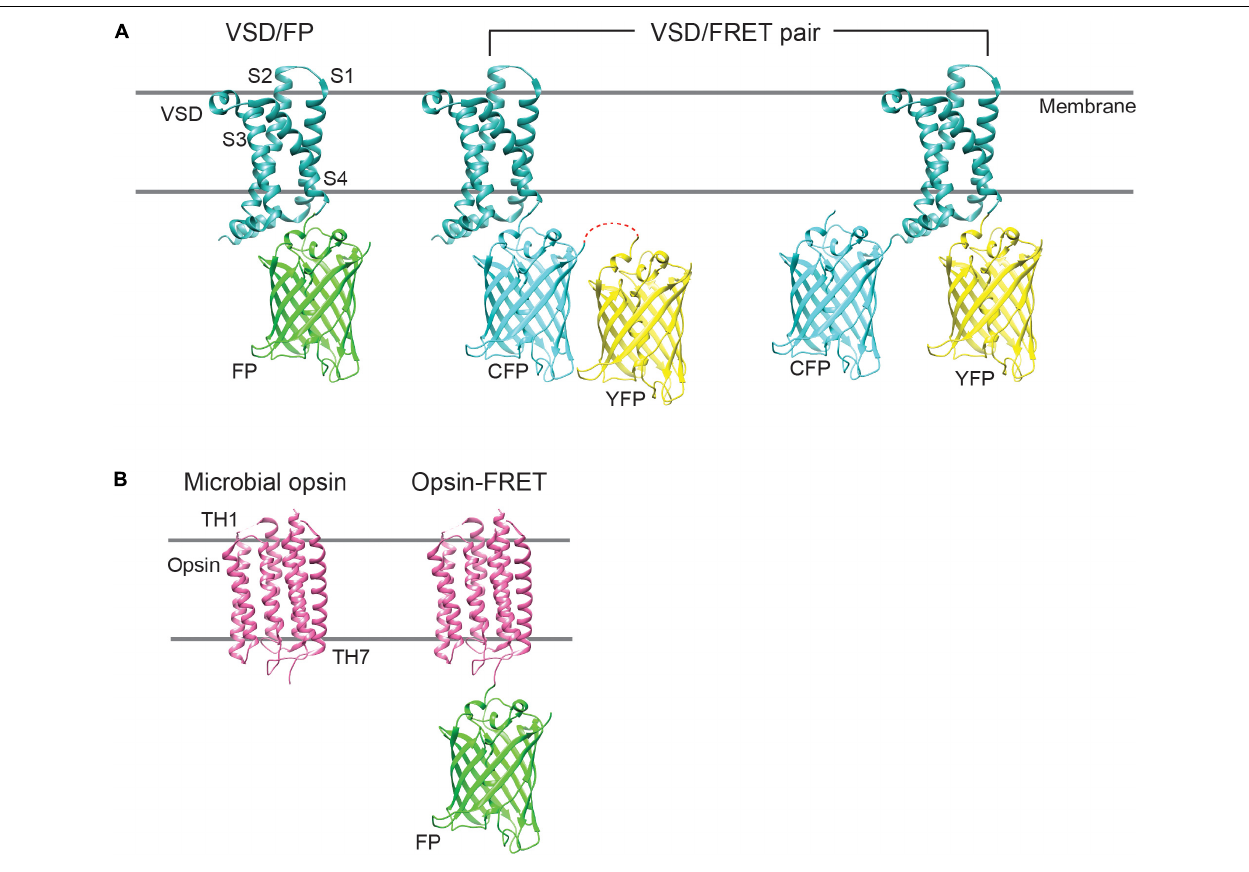
FIGURE 1 | Cartoon showing the different GEVI designs. (A) The majority of type 1 GEVIs consist of a molecular fusion of an isolated VSD, derived from a voltage-sensitive phosphatase, and a single FP, or a FRET FP pair. In FRET constructs, the FPs may be fused in tandem or to either terminus of the VSD. CFP, cyan fluorescent protein; YFP, yellow fluorescent protein. (B) Type 2 GEVIs comprise standalone microbial opsins, which possess seven transmembrane helices (TH1–TH7), or opsin-FRET constructs, where the opsin may be fused to a fluorophore. Microbial opsins exhibit broad absorption spectra (500–700 nm) and serve to “quench” the fluorescence of the appended fluorophore, during voltage